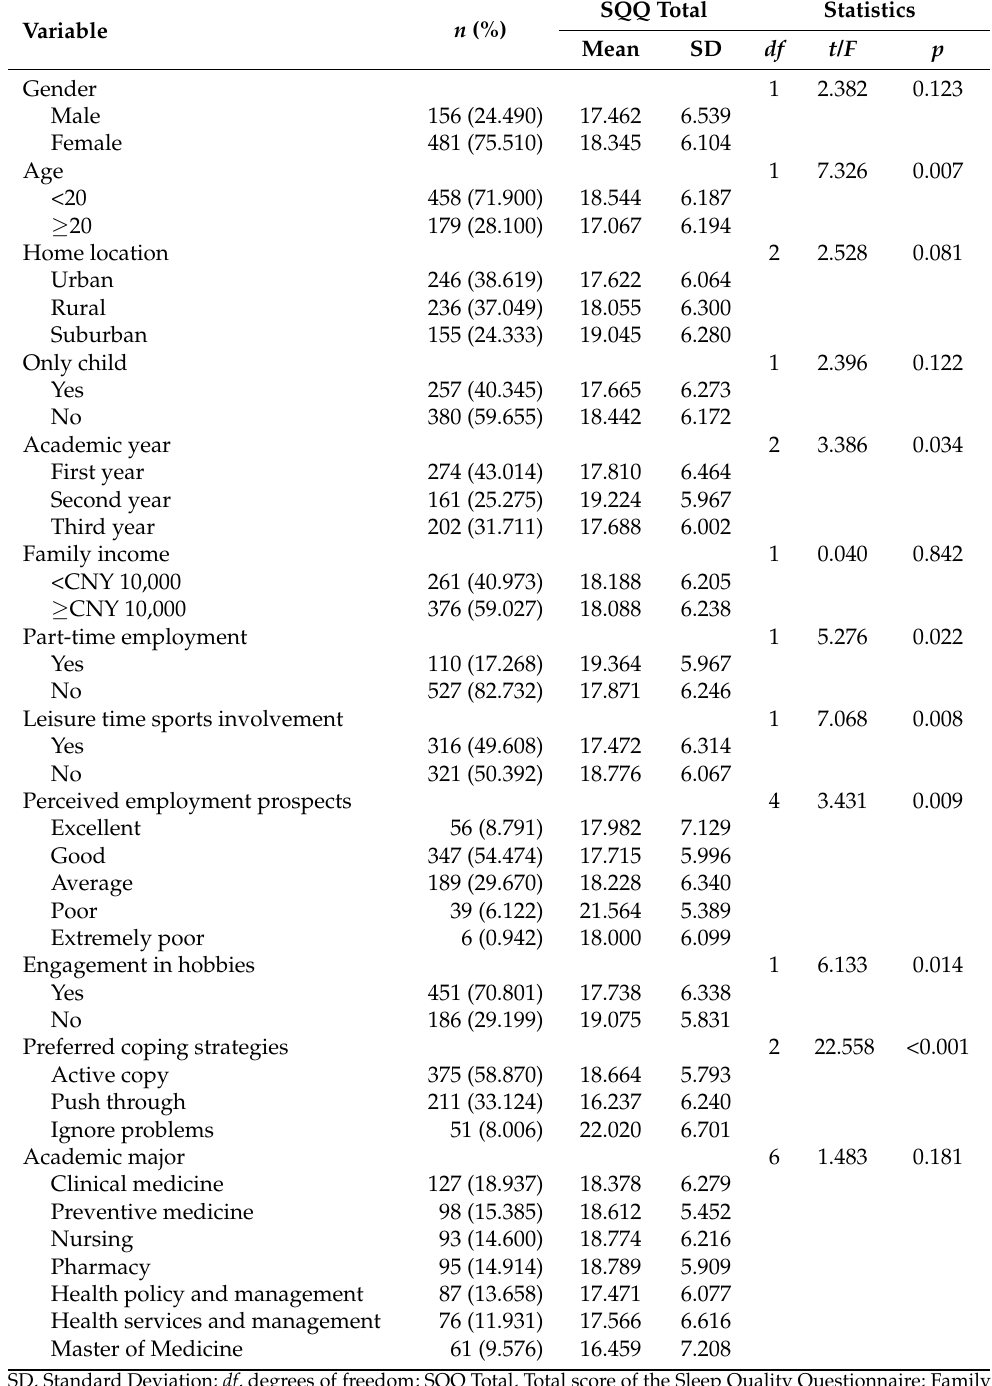
Table 1. Characteristics of participants ( n =